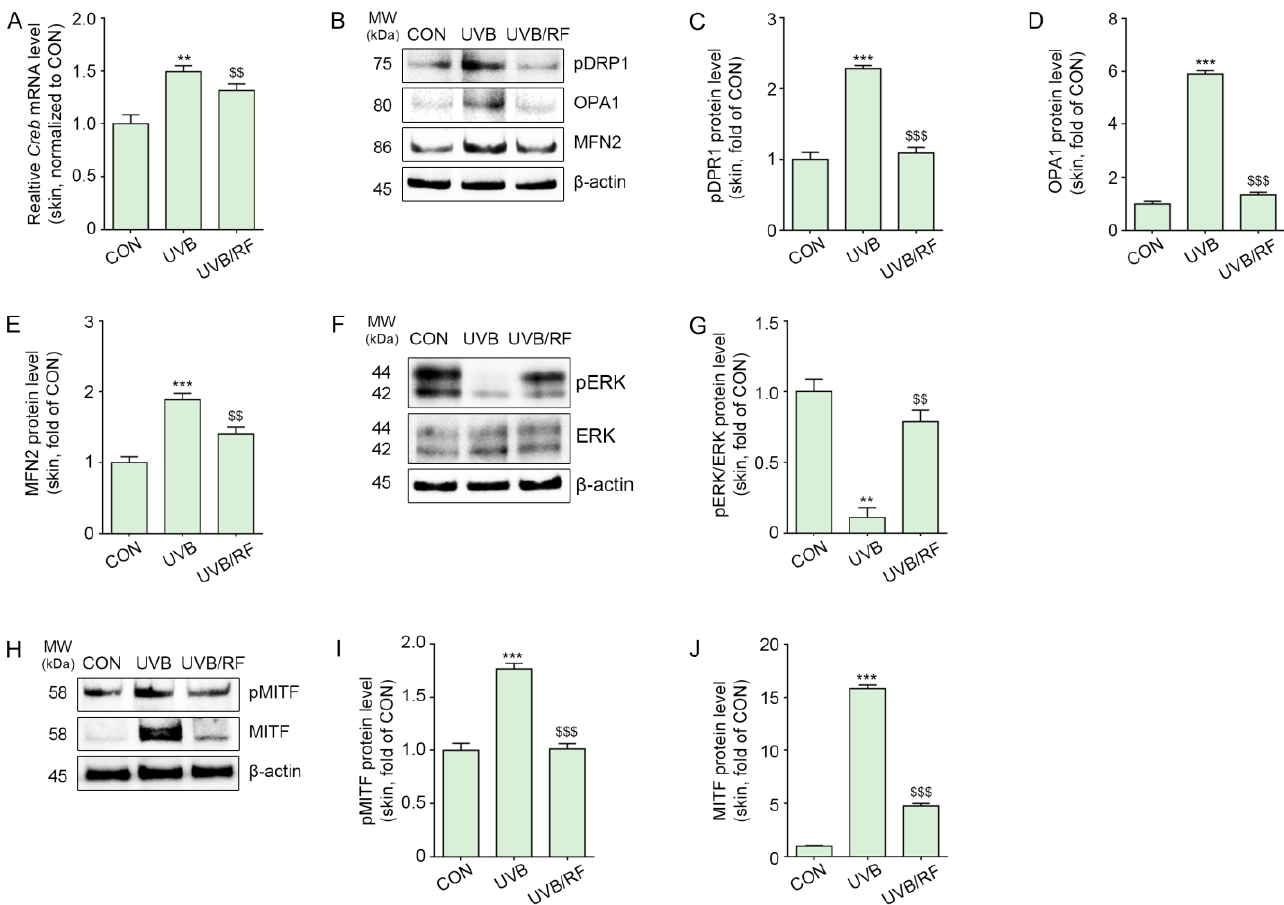
Figure 4. RF application decreased CREB/pDRP1/OPA1/MFN2/MITF in UVB-exposed mouse skin. Mice were either not exposed or exposed to UVB nine times for 5 min each for 14 d (CON or UVB group), and then RF was irradiated (UVB/RF group). ( A ) The mRNA levels of CREB in mouse skin were measured by qRT-PCR. ( B ) The protein expression of pDRP1/OPA/MFN2 in mouse skin was measured by Western blot. ( C – E ) Quantitative graph for Western blot of ( B ). ( F ) The protein expression of pERK1/2/ERK1/2 in mouse skin was determined by Western blot. ( G ) Quantitative graph of the Western blot of ( F ). ( H ) The protein expressions of pMITF and MITF in mouse skin were measured by Western blot. ( I , J ) Quantitative graph for Western blot of ( H ). Data are presented as the mean ± SD of three independent experiments. **, p < 0.01; ***, p < 0.001, second bar vs. first bar; $$, p < 0.01, $$$ < 0.001, third bar vs. second bar (Mann–Whitney U test). CON, control; CREB, cyclic adenosine monophosphate response element-binding protein; d, days; MFN2, mitofusin 2; min, minutes; MITF, microphthalmia-associated transcription factor; MW, molecular weight; OPA1, optic atrophy type 1; pDRP1, phosphorylation of dynamin-related protein 1; pMITF, phosphorylation of microphthalmia-associated transcription factor; qRT-PCR, quantitative real-time polymerase chain reaction; RF; RF, radiofrequency; UVB, ultraviolet